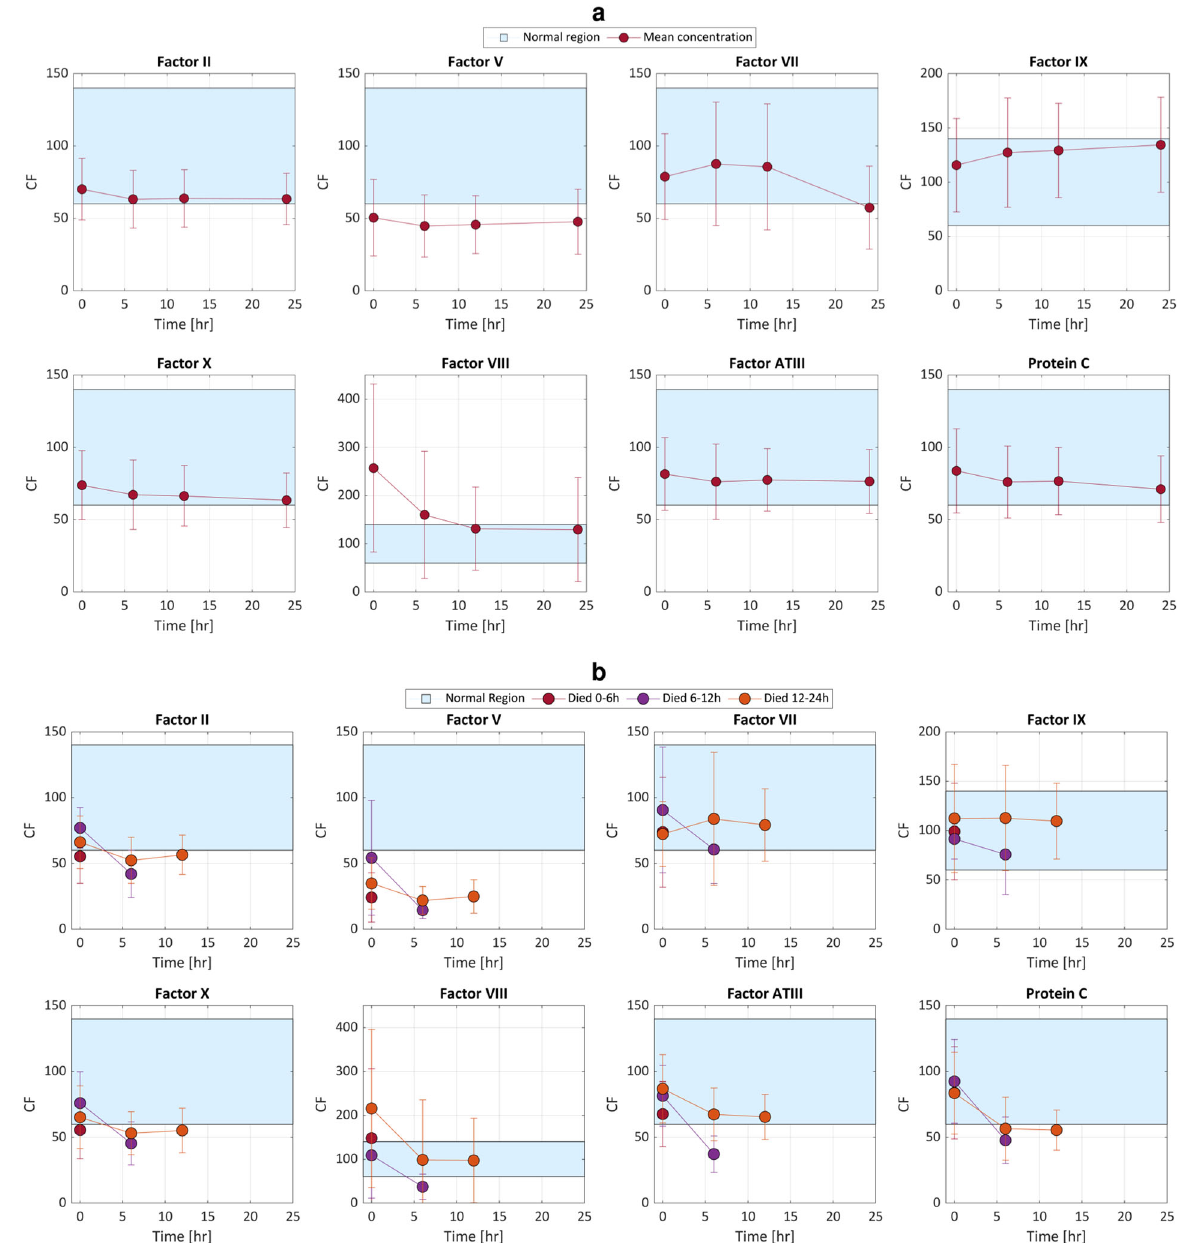
Fig. 4 Trauma patient coagulation factor concentration time history over the fi rst 24 h. a Mean ± one standard deviation of the concentrations of coagulation factors (CFs) during the fi rst 24 h after hospital admission, for factors II, V, VII, VIII, IX, X, ATIII, and protein C of 252 trauma patients, dataset 2 (demographics in Supplementary Fig. 5a). On average, the coagulation factor means converge to normal, where normal is the coagulation factor concentration range of 60 – 140% activity. b Mean ± one standard deviation of the CF concentrations for another 96 patients that died in the fi rst 24 h after hospital admission, dataset 3, grouped by mortality time window. On average, the coagulation factor means converge outside normal. Units of coagulation factor concentrations are reported as percent